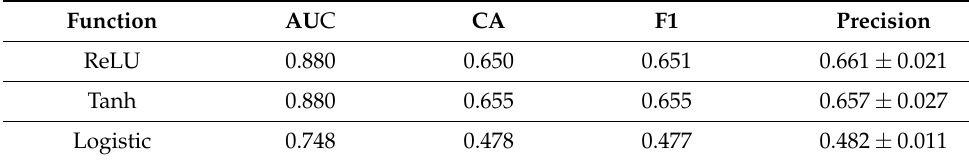
Table 2. The best results before the M3GP transformation of the dataset.